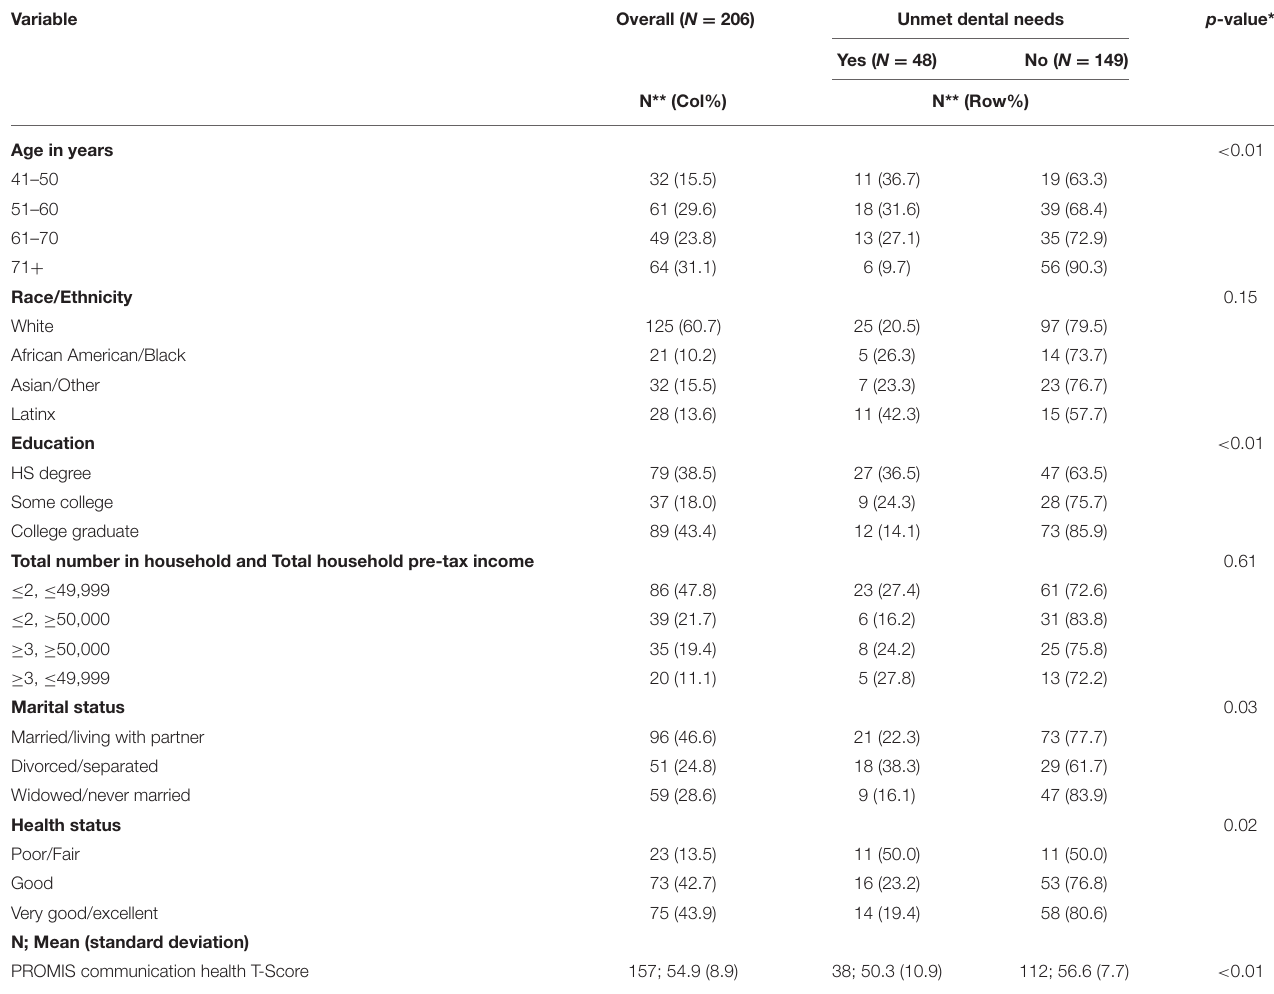
TABLE 1 | Distribution of characteristics of 195 women-overall and by unmet dental needs status.